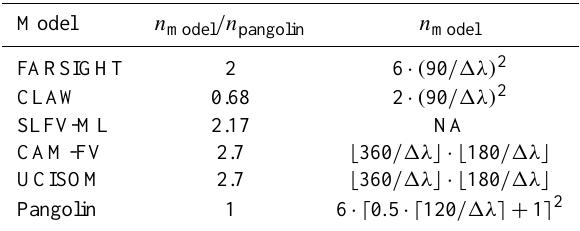
Table 1. For a given resolution at the Equator, we compare the total number of cells of each model n model vs. the total number of cells of Pangolin n pangolin